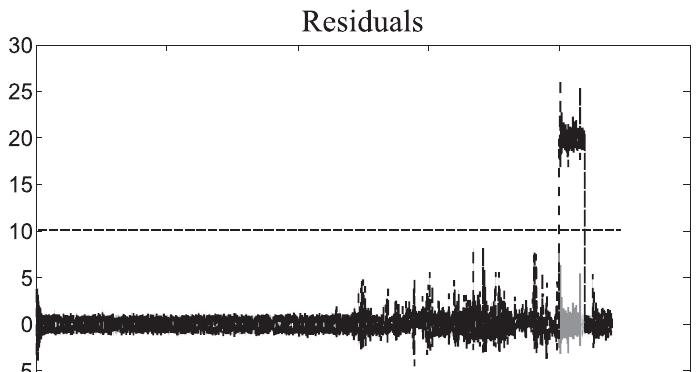
( t ) for the fault Case 9 O i